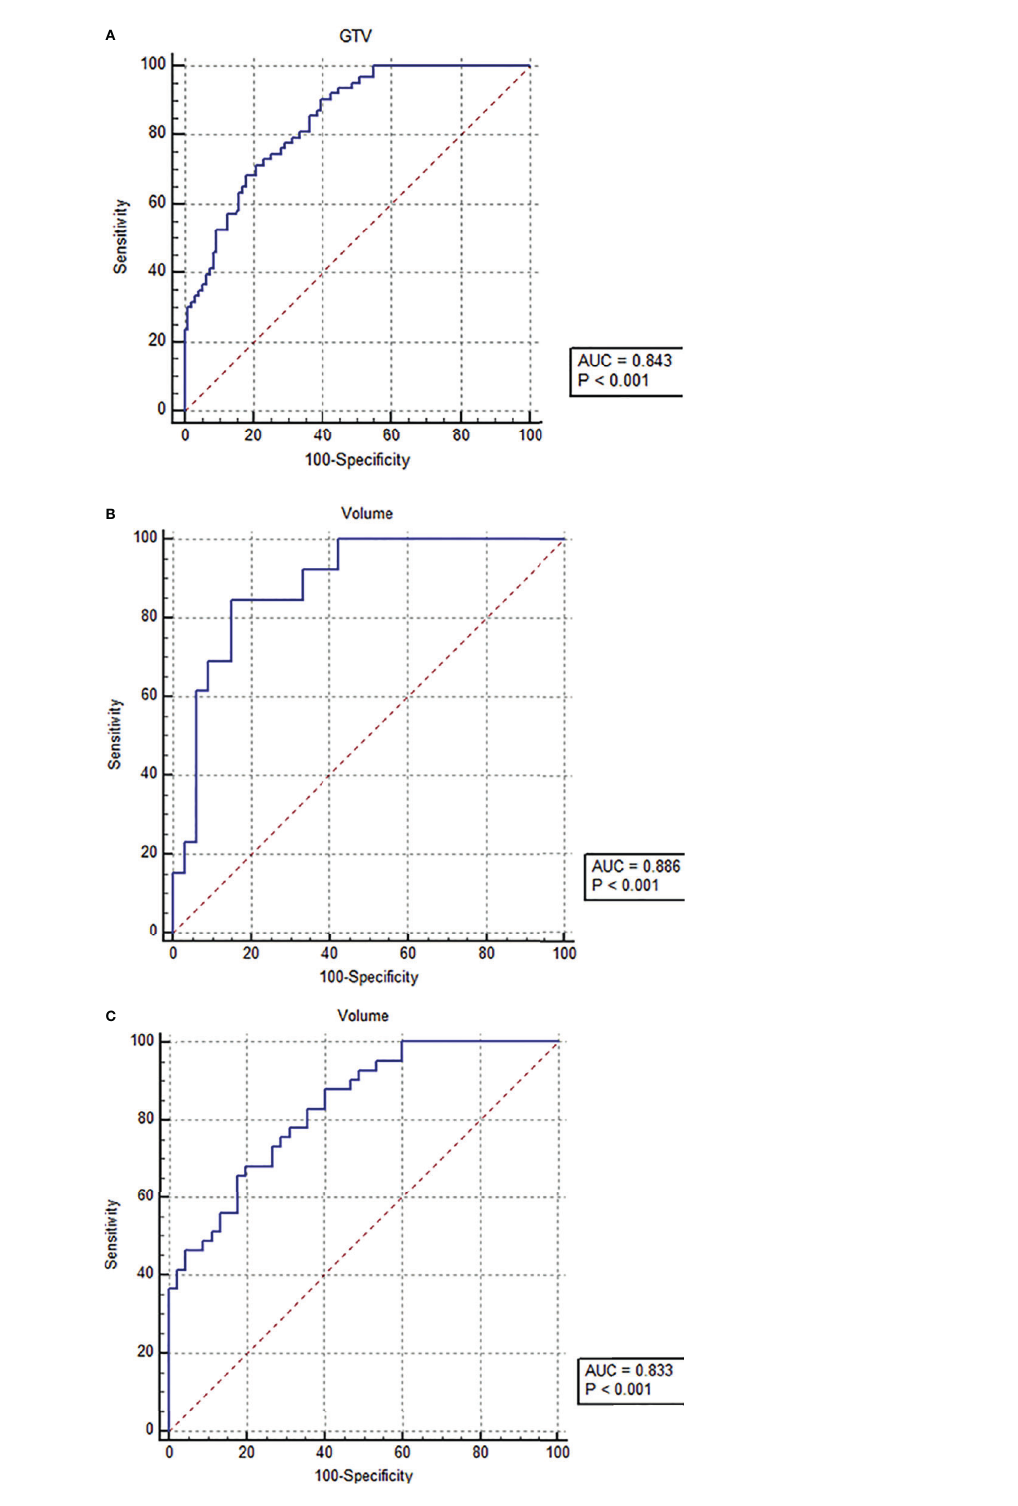
FIGURE 3 | Receiver operating characteristic (ROC) analysis of tumor stage-based gross tumor volume (GTV) has been performed for predicting early recurrence of esophageal squamous cell carcinoma after esophagectomy, and the ROC curves show that the GTV can help predict early recurrence in tumor stages cT 1-4a (A) , cT 2 (B) , and cT 3 (C) with the cutoff values of 13.31, 17.22, and 17.83 cm 3 ,